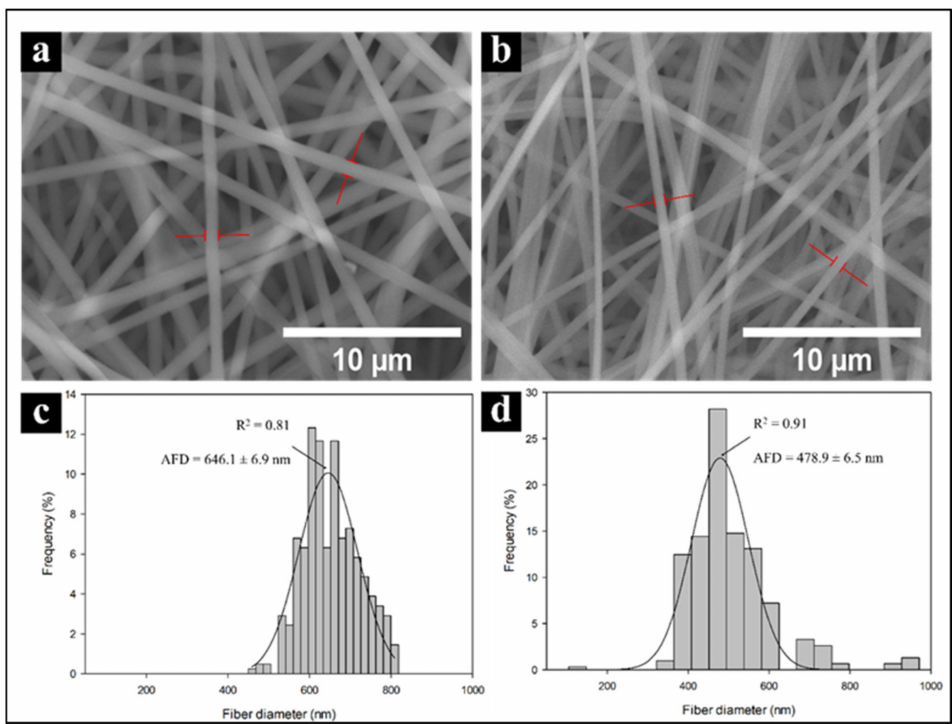
Figure 4. Scanning electron micrographs and histograms of fiber diameters for PVA nanofibers ( a , c ) and PVA + CNx nanofibers ( b , d ). AFD = average fiber